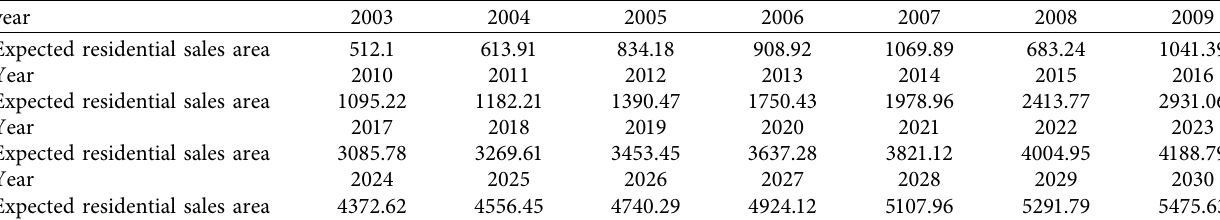
Table 3: Table function of expected residential sales area.